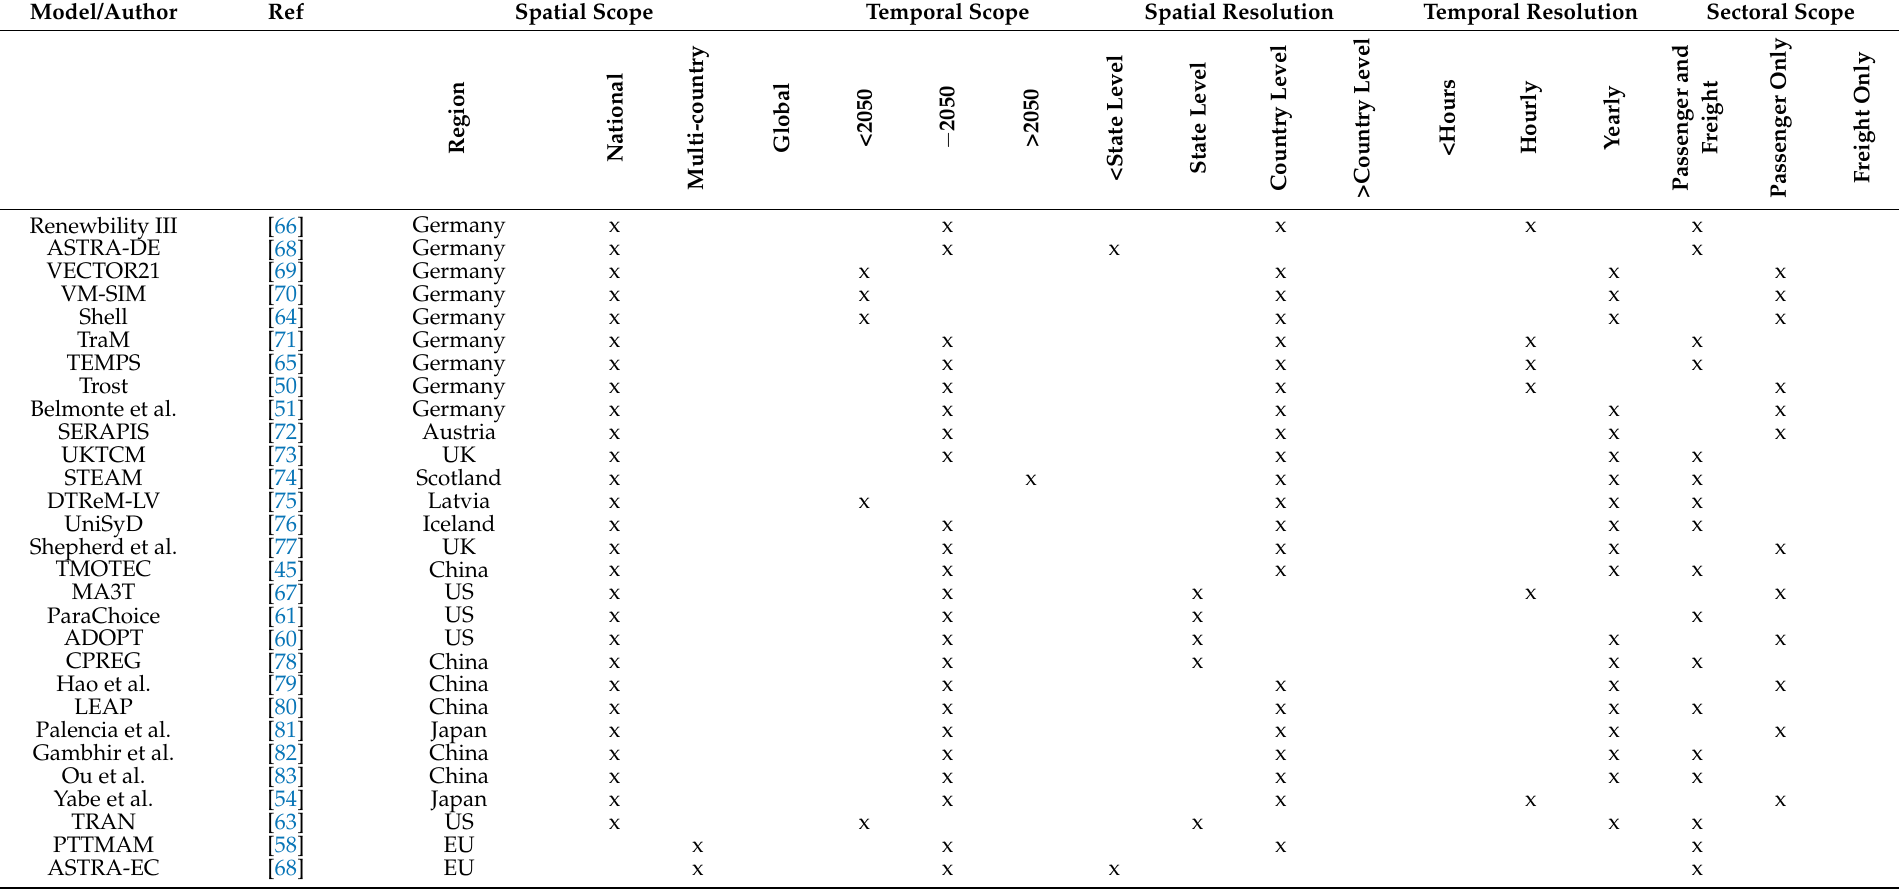
Table A1. Spatio-temporal properties and sectoral scope of investigated